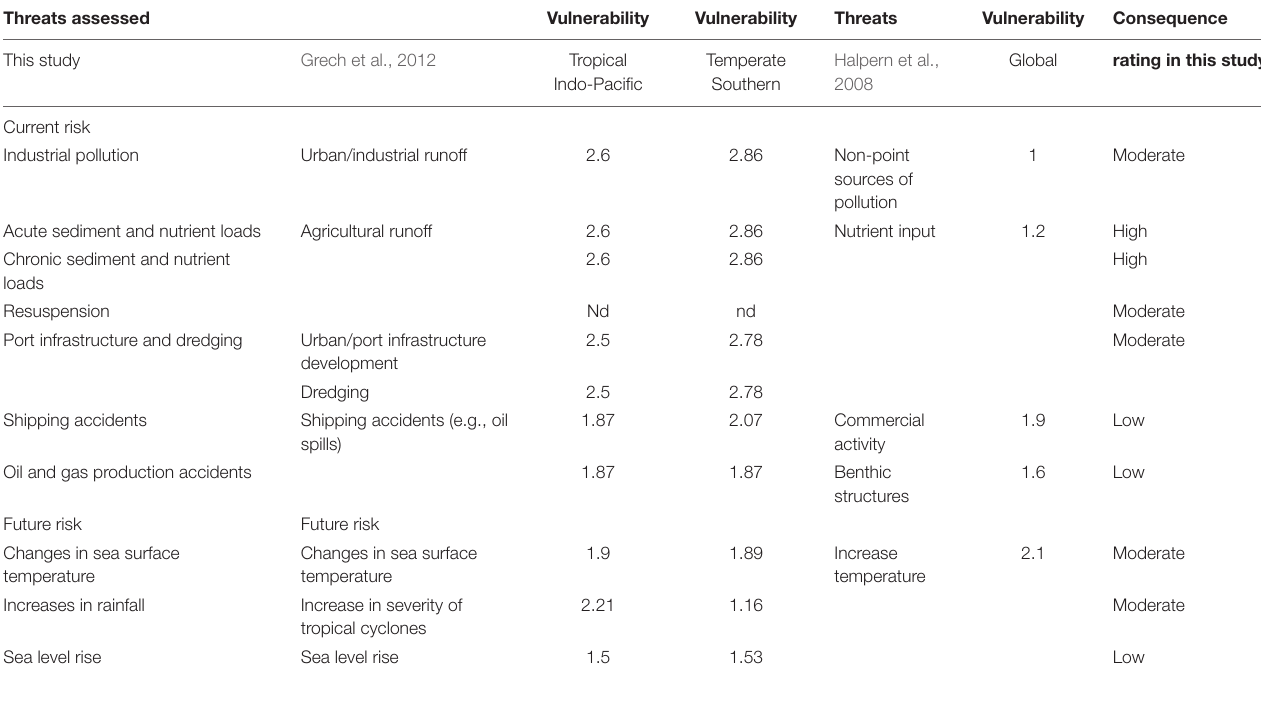
TABLE 2 | A comparison of the vulnerability measure for each threat addressed in this study in comparison to other studies that have assessed the vulnerability of threats to seagrass